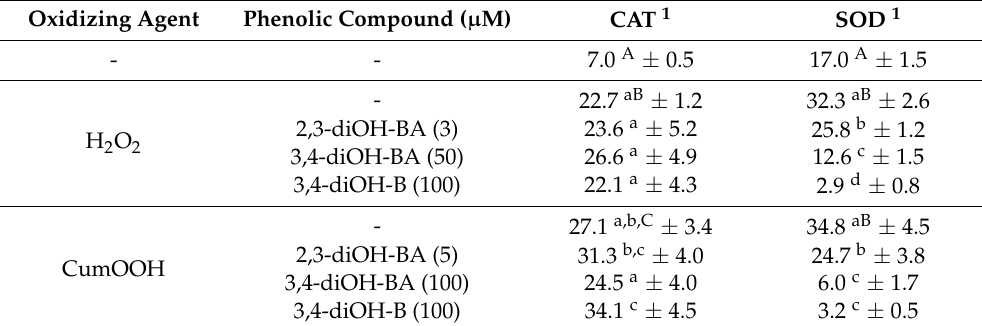
Table 3. Catalase (CAT) and superoxide dismutase (SOD) activity in S. cerevisiae BY4741 cells treated with H 2 O 2 (5 mM) or CumOOH (150 µ M) in the absence/presence of the tested phenolic compounds. Oxidizing Agent Phenolic Compound ( µ